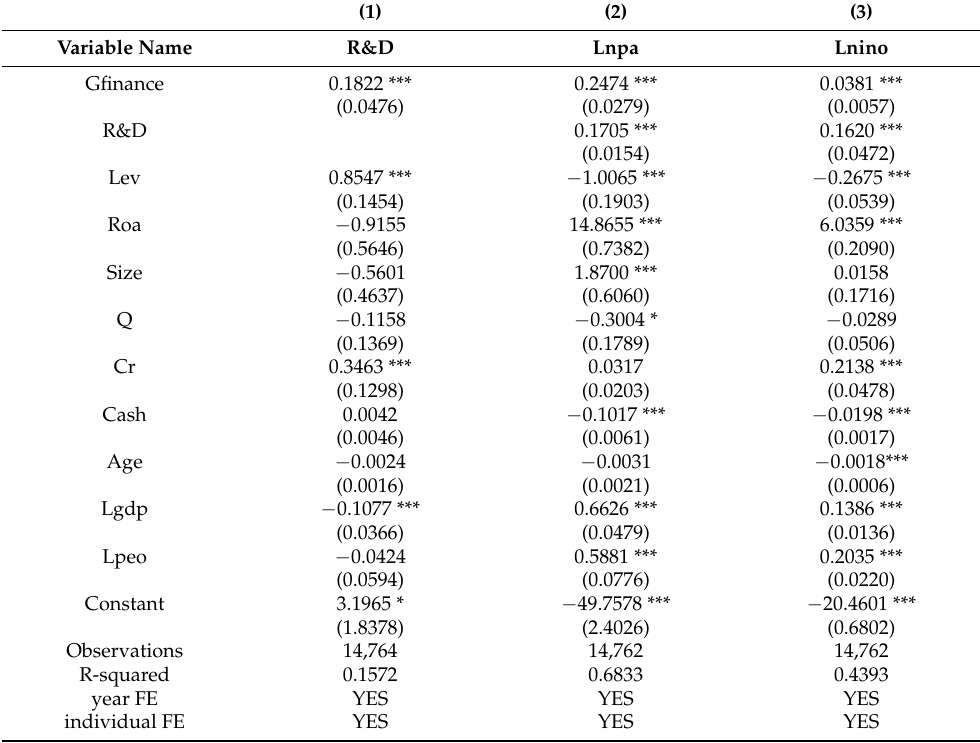
Table 6. Tests for mediating effects of R&D investment.